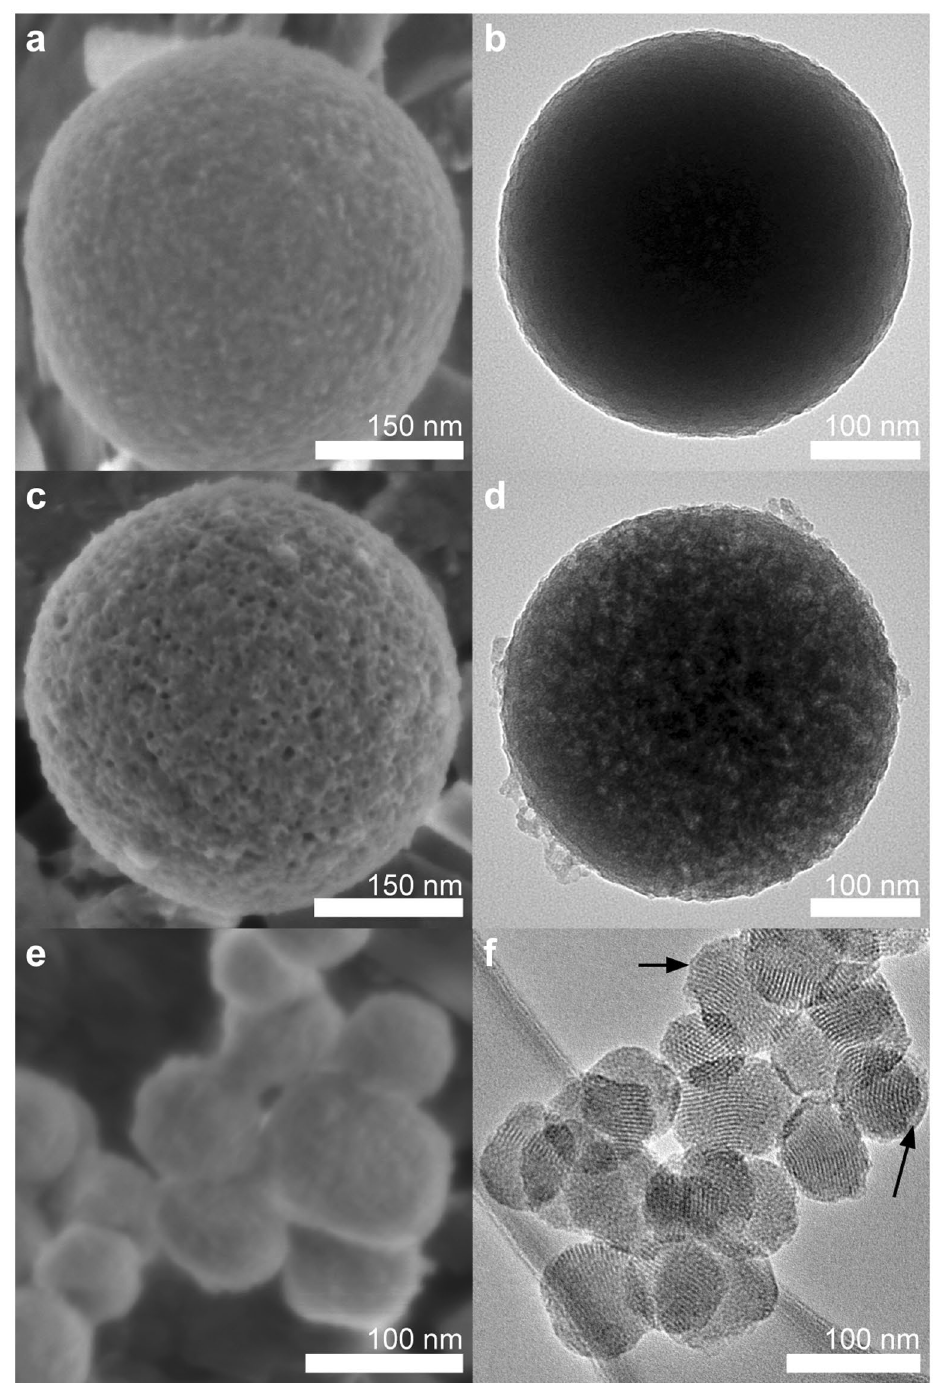
Figure 2. Microscopy of OCT-MSNs and control particles contrast the results of drug-templating and diffusion gradient drug loading. SEM and TEM micrographs of drug-templated MSNs before drug release ( a and b , respectively) show well defined and separated particles approximately 424 nm in diameter. Post-drug-release OCT-MSNs (SEM in c , TEM in d ) show very clear surface pore openings and well resolved pores throughout the particle. Control OCT-loaded MCM-41 (SEM in e , TEM in f ) exhibits fusing of particles and a layer of external drug (highlighted with